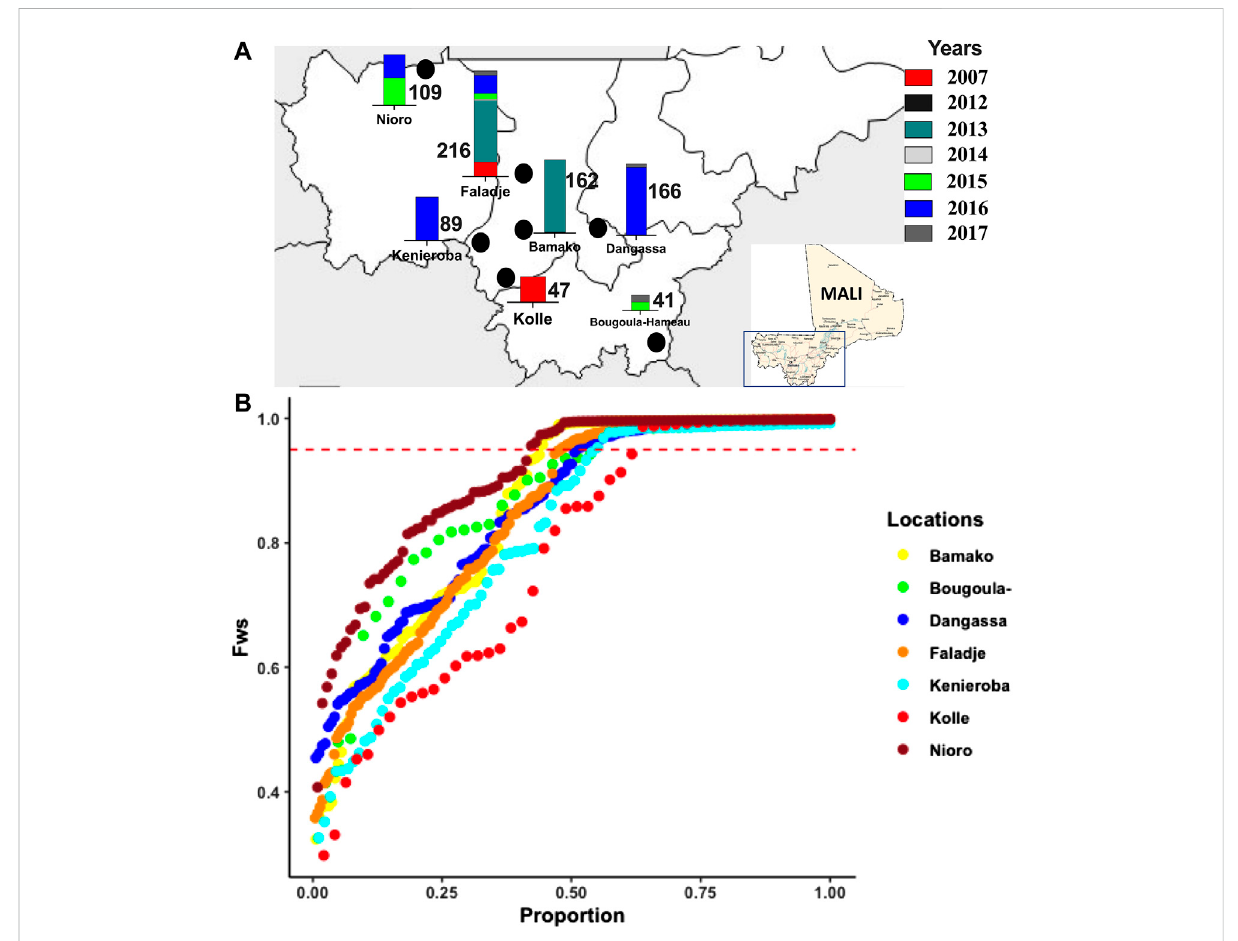
FIGURE 1 Geographic and temporal malaria parasites sampled across different endemic sites in Mali between 2007 and 2017, showing, (A) sampling locations in Mali (marked with black points), and bars of number of samples per location from different years as color-coded. (B) Distribution of the F WS inbreeding coef fi cient for infection complexity determined for isolates from different locations